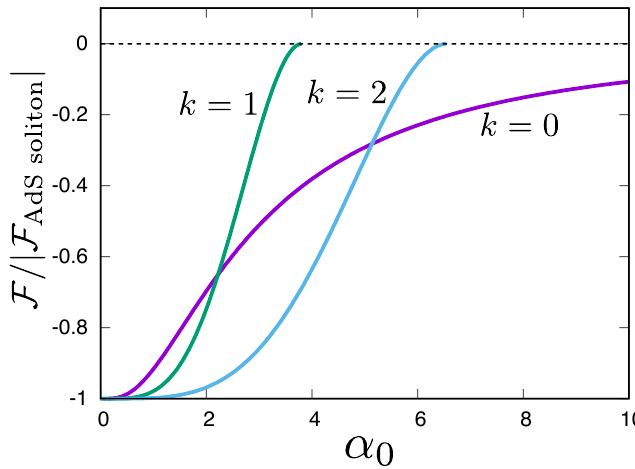
Figure 3. Free energy of the resonating AdS soliton as a function of (cid:11) 0